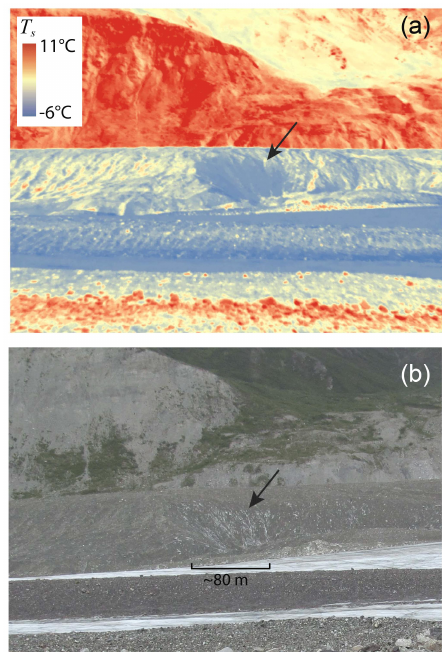
Figure 10. The side of a medial moraine on Canwell Glacier, possi- bly at an intermediate stage between being classified as an ice cliff or debris-covered area (black arrow in panels a and b ). (a) Oblique image of surface temperature ( T s ). The sharp boundary between blue and red in the middle of the image separates the top of the medial moraine and the off-glacier valley wall. (b) Oblique visible image of the same feature. Location shown in Fig. 2. Bare ice T s values below 0 ◦ C are likely due to camera calibration error and/or assuming a constant emissivity for the entire